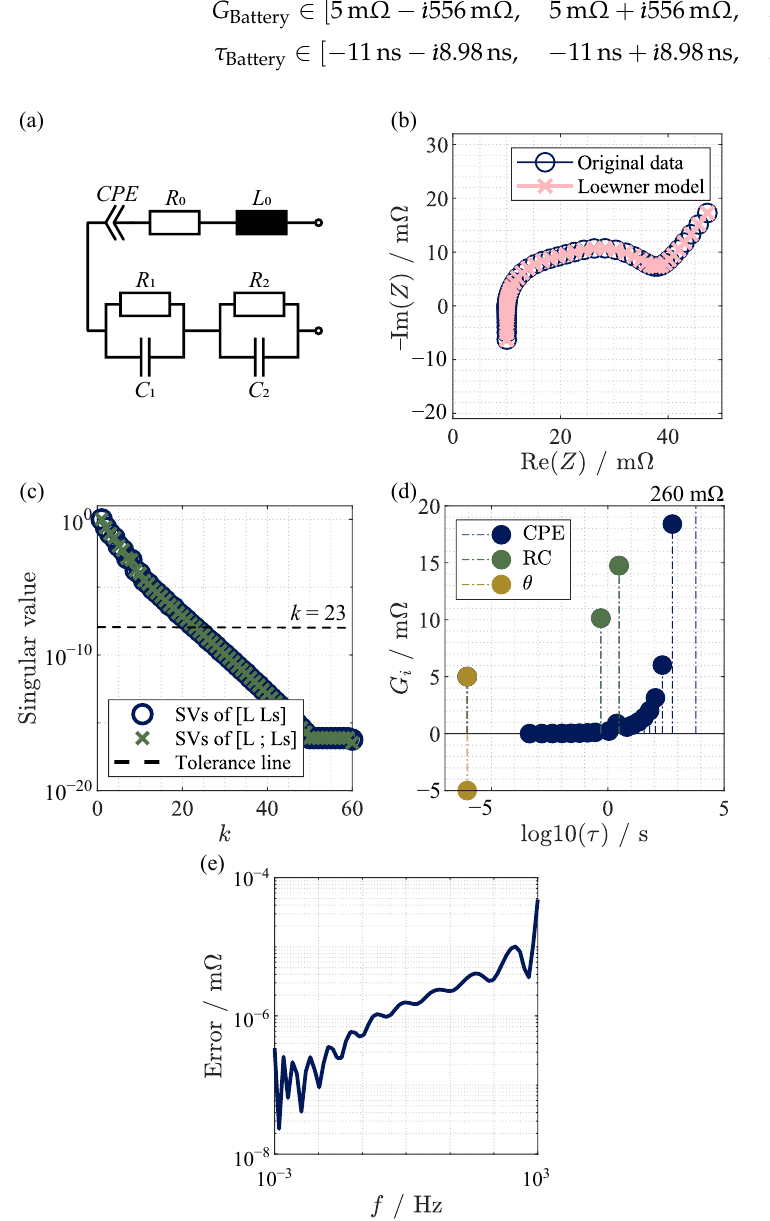
Figure 4. ECM for battery model ( a ), Nyquist plot of the impedance Z Battery ( b ), SVD of the Loewner matrices ( c ), DG ( d ), and error of magnitude ( e